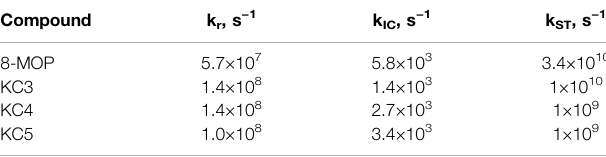
TABLE 4 | Rate constants of photophysical processes a of lower singlet excited states. The geometry of the molecular structure was optimized by the AM1.